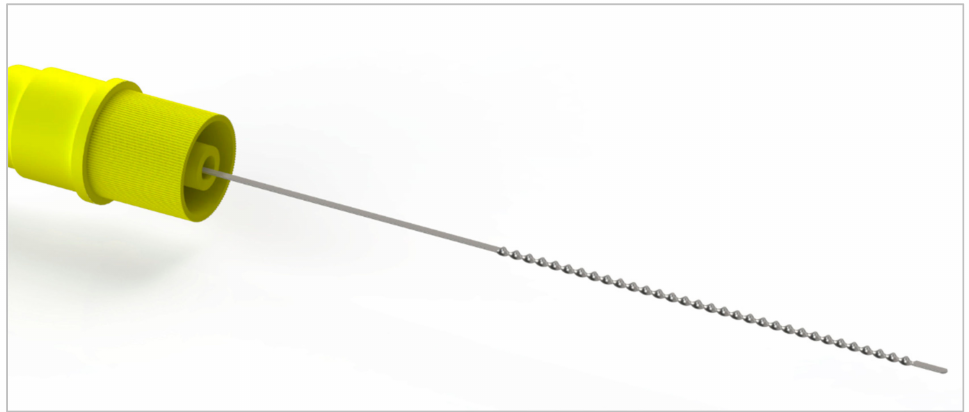
Figure 2. BMProbe is a medical-grade stainless steel wire with 32 windings. The windings are coated with a photoactive polymer and IgG-Ab that isolate specific rare cells from the venous bloodstream. The yellow IN-connector is screwed onto an indwelling cannula (18G × 1 1 cubital